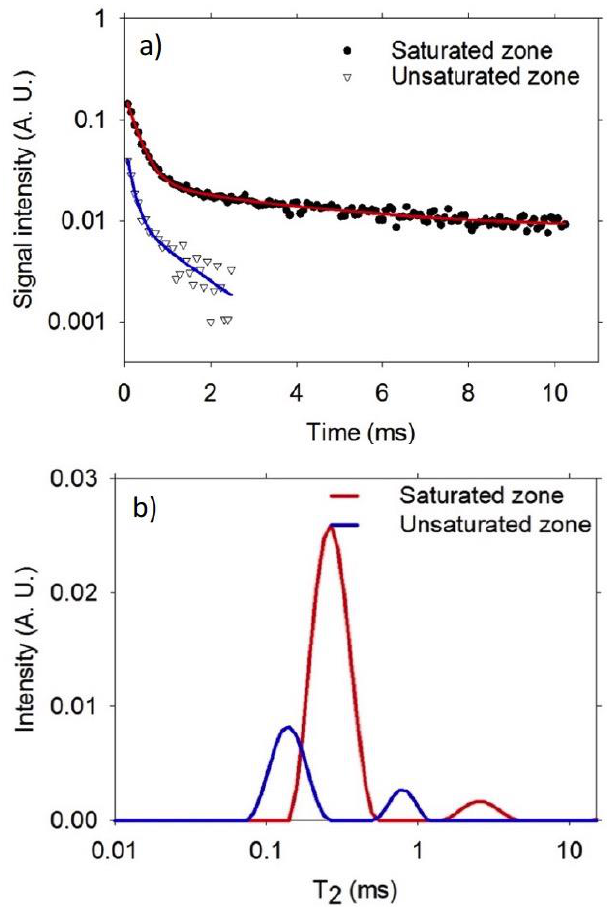
Figure 4. ( a ) CPMG decay in saturated and unsaturated zones of a 0.60 w/c ratio mortar sample, and ( b ) T 2 distributions corresponding to the CPMG decays shown in ( a ).